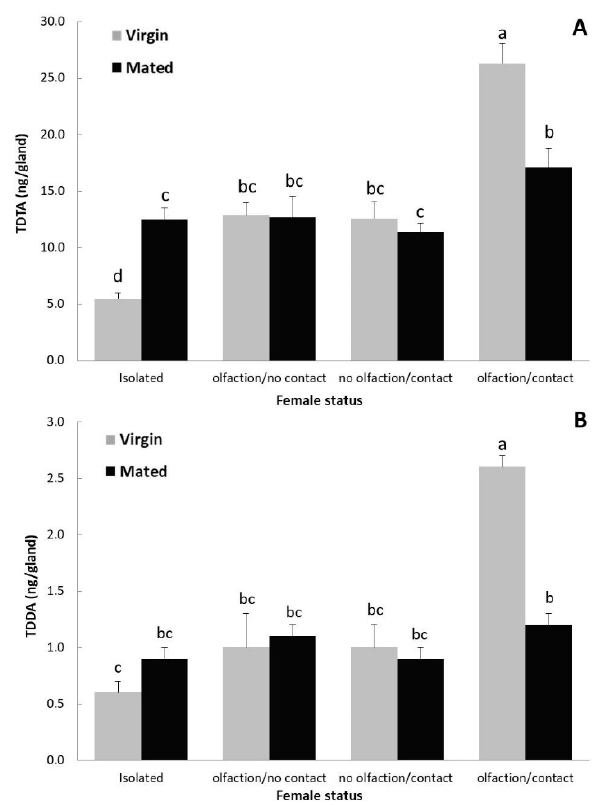
Figure 2. Pheromone components production (mean + SE) (TDTA in A ; TDDA in B ) by 2-day old virgin and mated T. absoluta females (N = 7–13 extracts) in the absence (isolated) and presence (olfaction/no contact, no olfaction/contact, olfaction/contact) of the host plant. Bars with different letters within the same pheromone component are statistically different (Kolmogorov and Tukey and post hoc test for TDTA and TDDA respectively, p < 0.05).